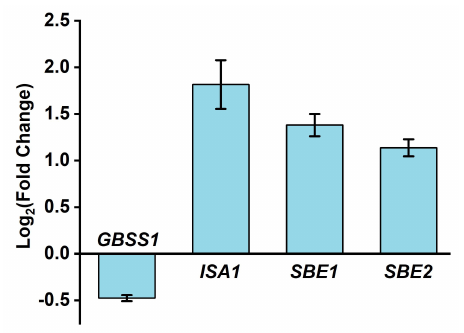
Figure 6. Changes of gene expression in leaves at the filling stage (5 September 2020) showing that HNW might decrease amylose accumulation. Transcripts of GBSS1 , ISA1 , SBE1 , and SBE2 were analyzed by qPCR. Data are mean ± SD (n = 3).